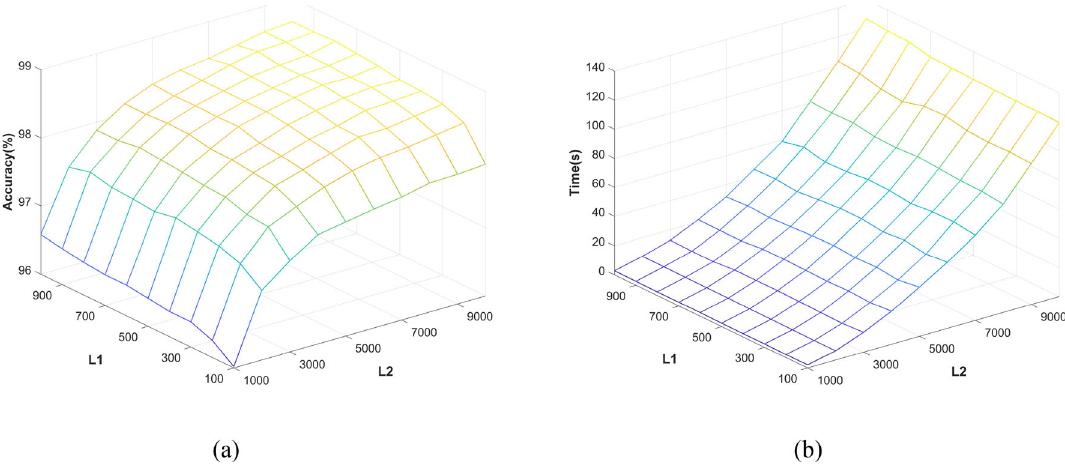
Fig. 8 The influence of the hidden nodes on a accuracy and b training time